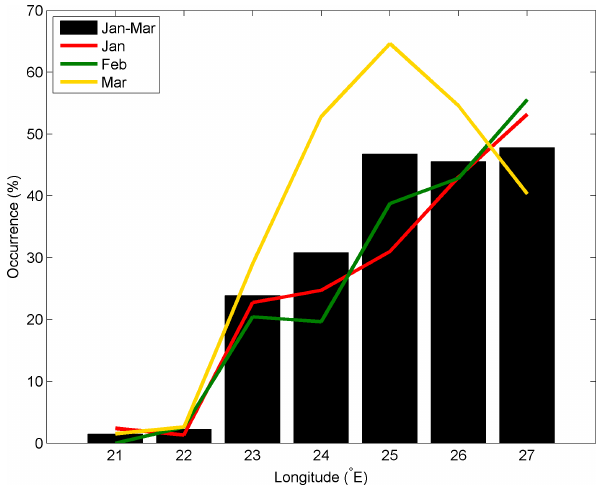
Figure 9. The occurrence of > 0 . 5kgm − 3 density difference be- tween 40m depth and the sea surface in the Gulf of Finland from January to March 1904–2020. A total of 2560 temperature–salinity data pairs for the surface layer and 40m depth are